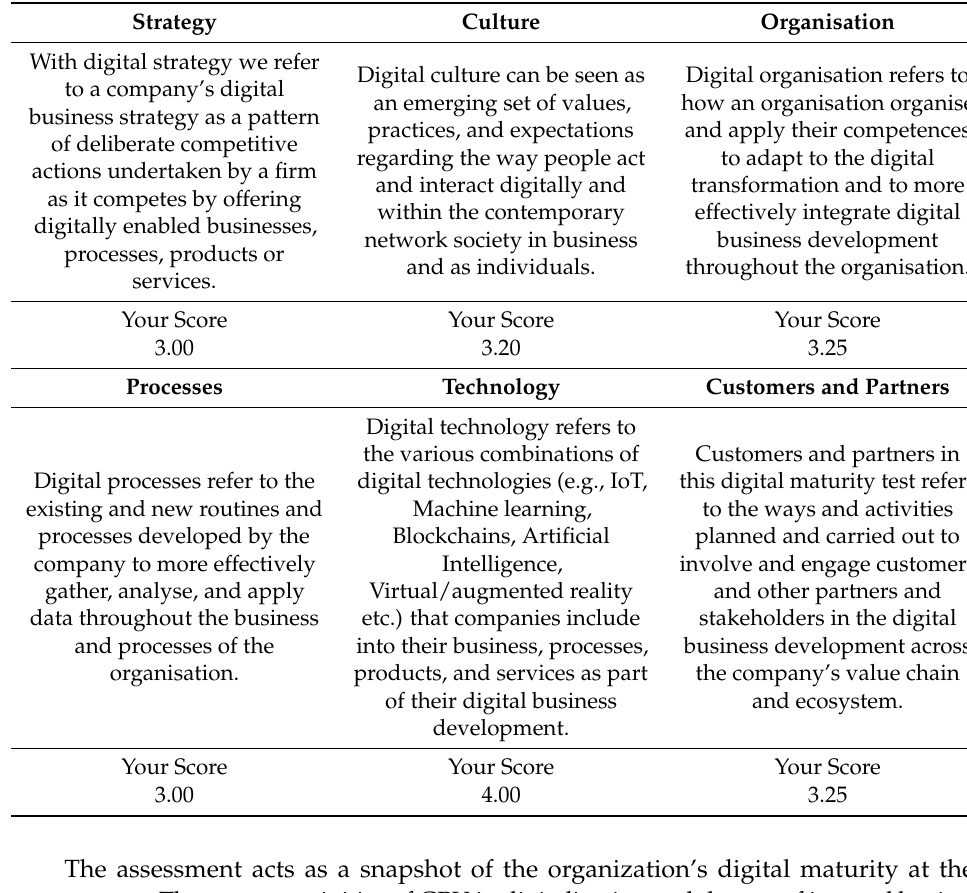
Table 1. Digital Maturity Assessment of GPV with DMAT tool.